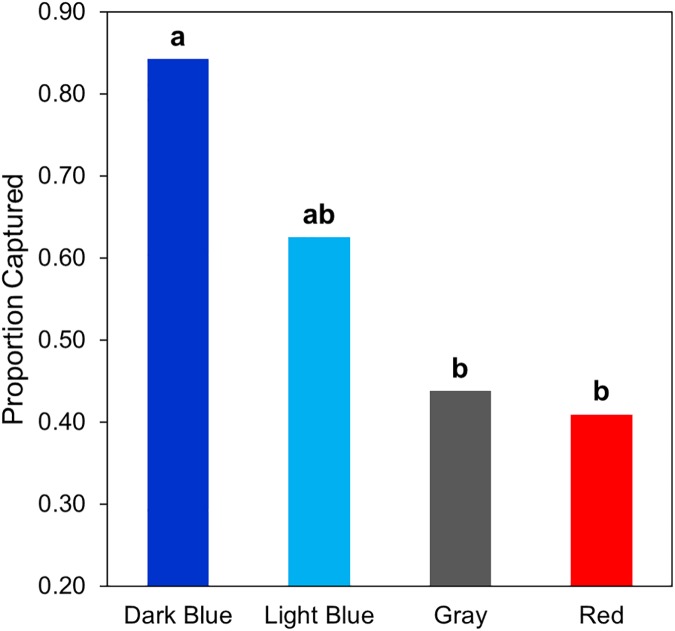
Proportion of lizards that were captured after the FID trial for each color of T-shirt (data from both sites pooled).Letters denote significant (p < 0.05) differences among colors from post-hoc comparisons made using the false discovery rate.